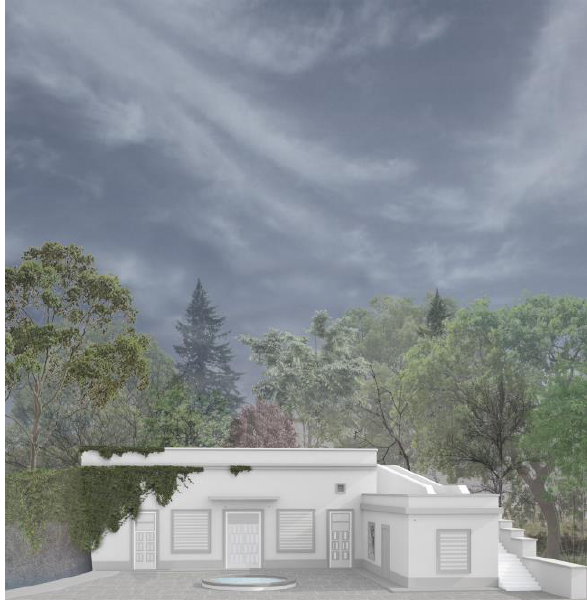
Figure 14. The Royal Park of Tirana. Render of the greenhouses.